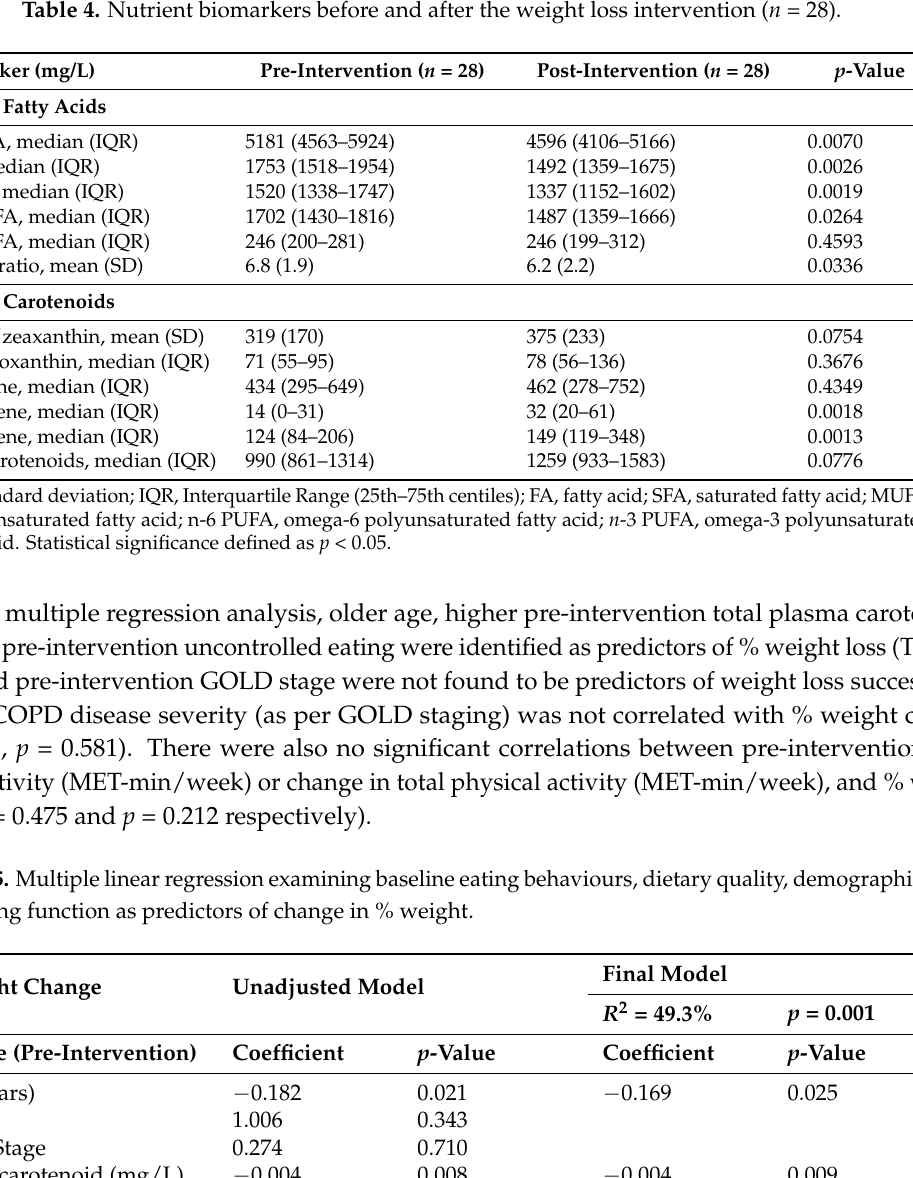
Table 4. Nutrient biomarkers before and after the weight loss intervention ( n = 28).